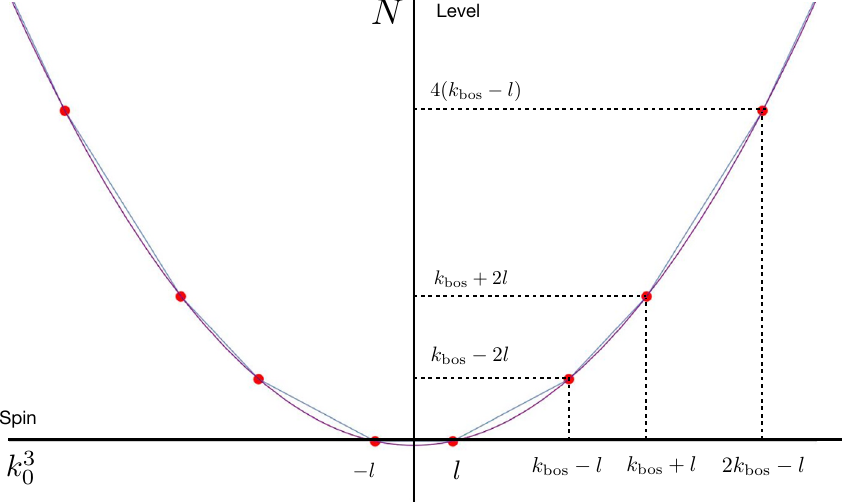
Figure 3 . The weight diagram of an irreducible su (2) current algebra module. The border of the weight diagram is given by the (blue) straight lines. The circumscribing (purple) parabola touches the weight diagram if and only if we are at a spectral flowed ground state, indicated by (red)